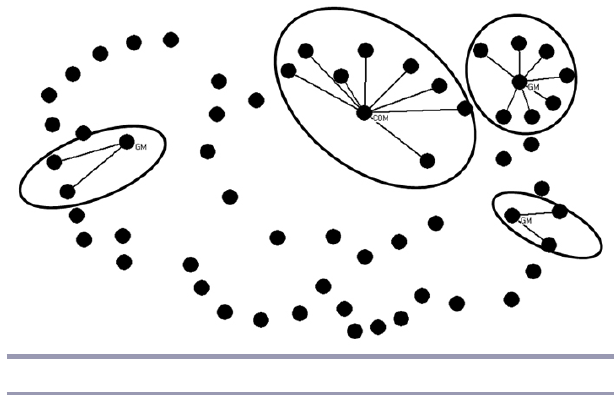
Fig. 8 . Landcare Group B (LGB) interest clusters - water and